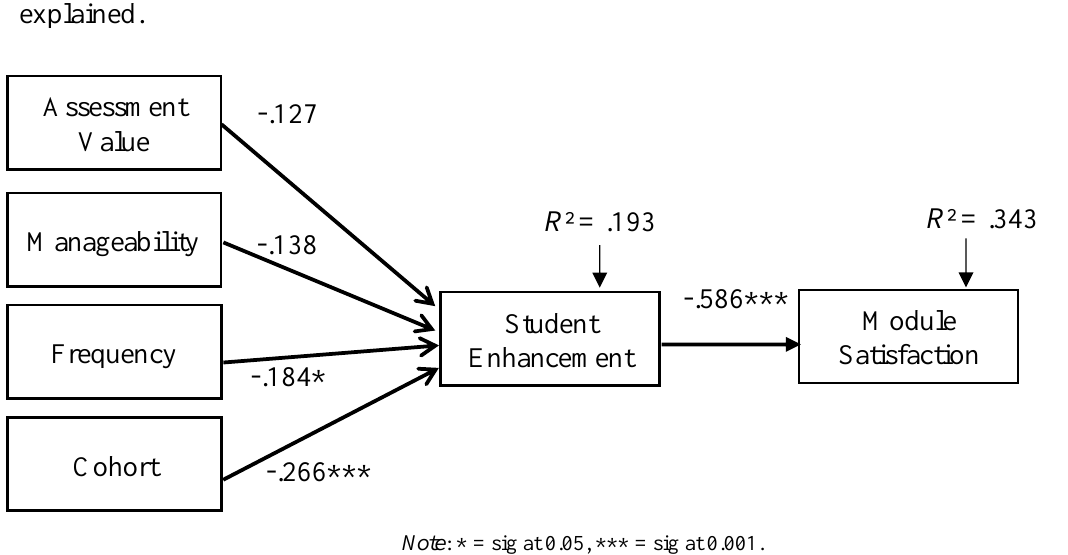
Figure 1: Module Satisfaction and Student Enhancement Prediction